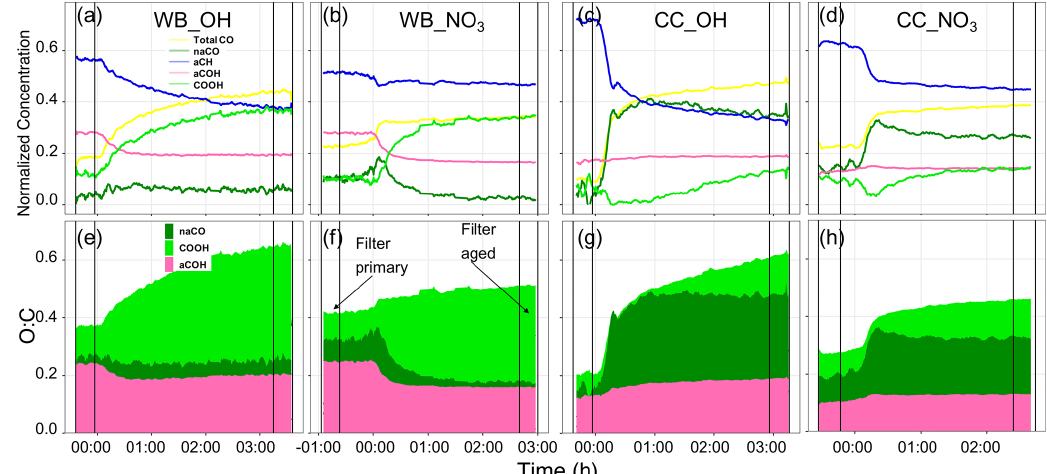
Figure 8. Time series of normalized concentration of functional groups interpolated using AMS mass spectra (a–d) and time series of O : C ratios calculated from the interpolated functional groups (e–h) . An example for each source (CC and WB) and oxidant (OH and NO 3 ) has been shown. The time zero indicates the start of aging (UV lights turned on or oxidant injected). The horizontal lines indicate the periods of filter